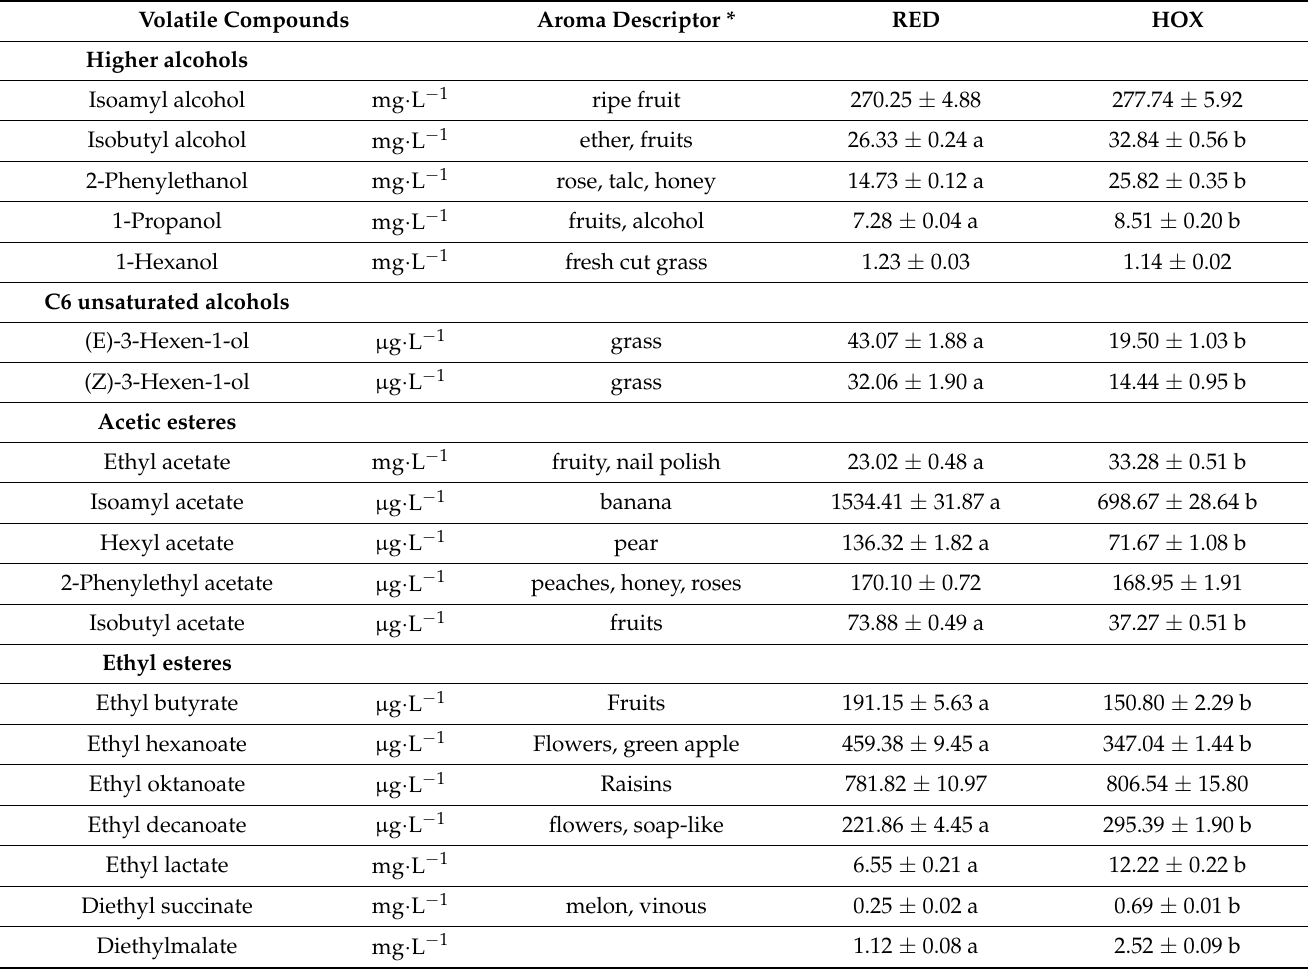
Table 2. Concentrations of volatile aroma compounds in final